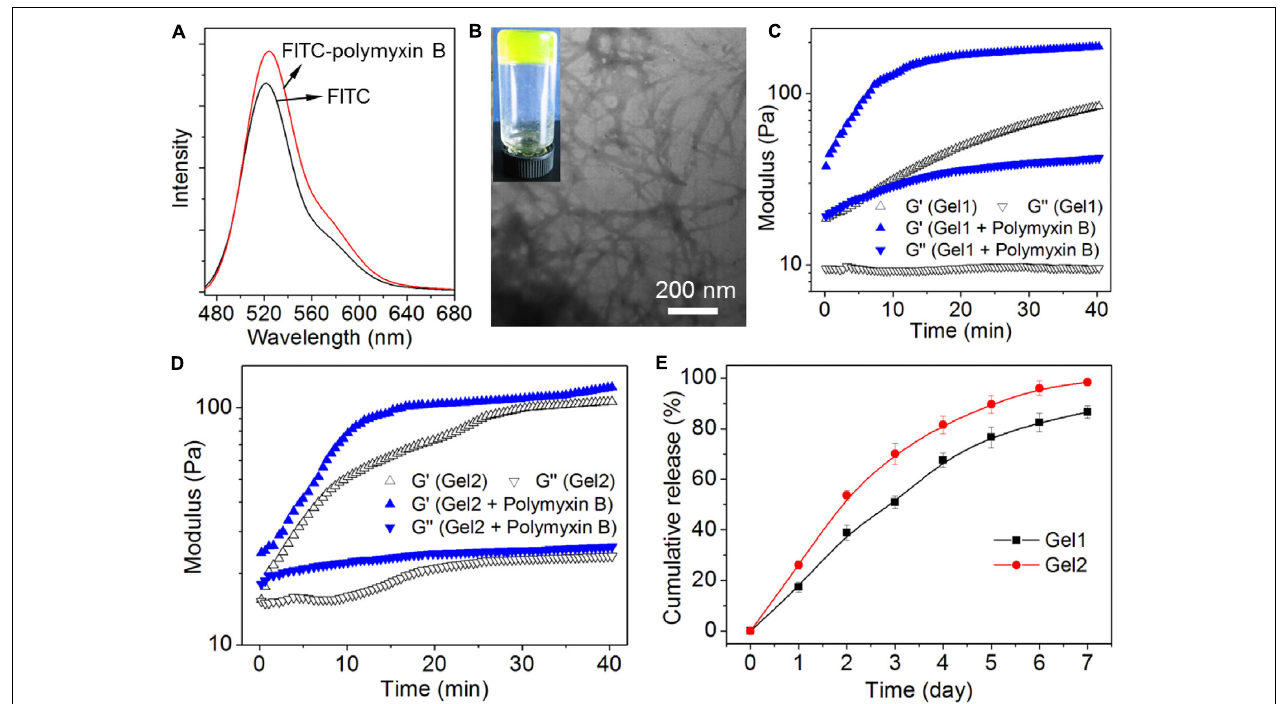
FIGURE 4 | (A) Fluorescent emission spectrum of FITC-polymyxin B in aqueous solution. (B) Photo and TEM images of the hydrogel of peptide 1 (Gel1) loading FITC-polymyxin B. (C,D) Oscillatory rheology behaviors of Gel1 (C) and Gel2 (D) loading FITC-polymyxin B. (E) Cumulative release profile of polymyxin B encapsulated into Gel1 and Gel2 in PBS solution.